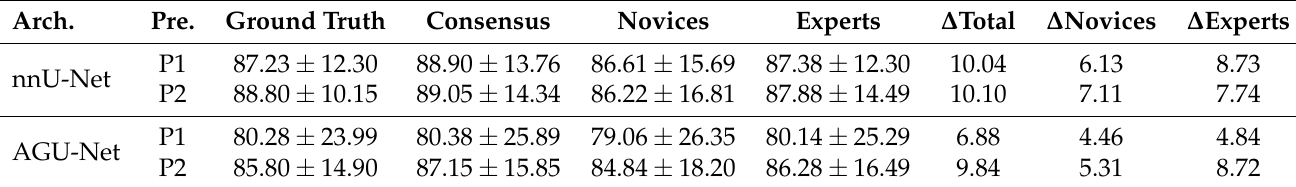
Table 7. Inter-rater Dice score variability, averaged over the 20-patient subset from the AMS hospital, for the two architectures and preprocessing schemes. The ∆ columns indicate the average patientwise Dice score variations across the different categories of